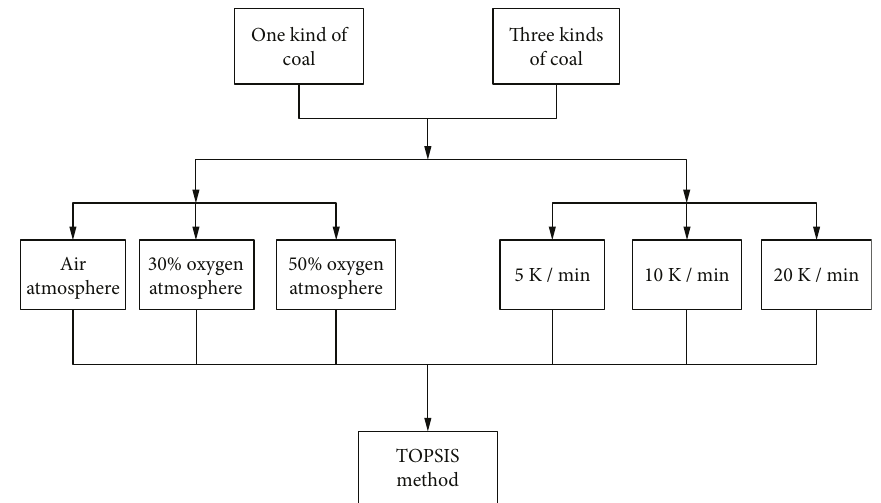
Figure 1: Research